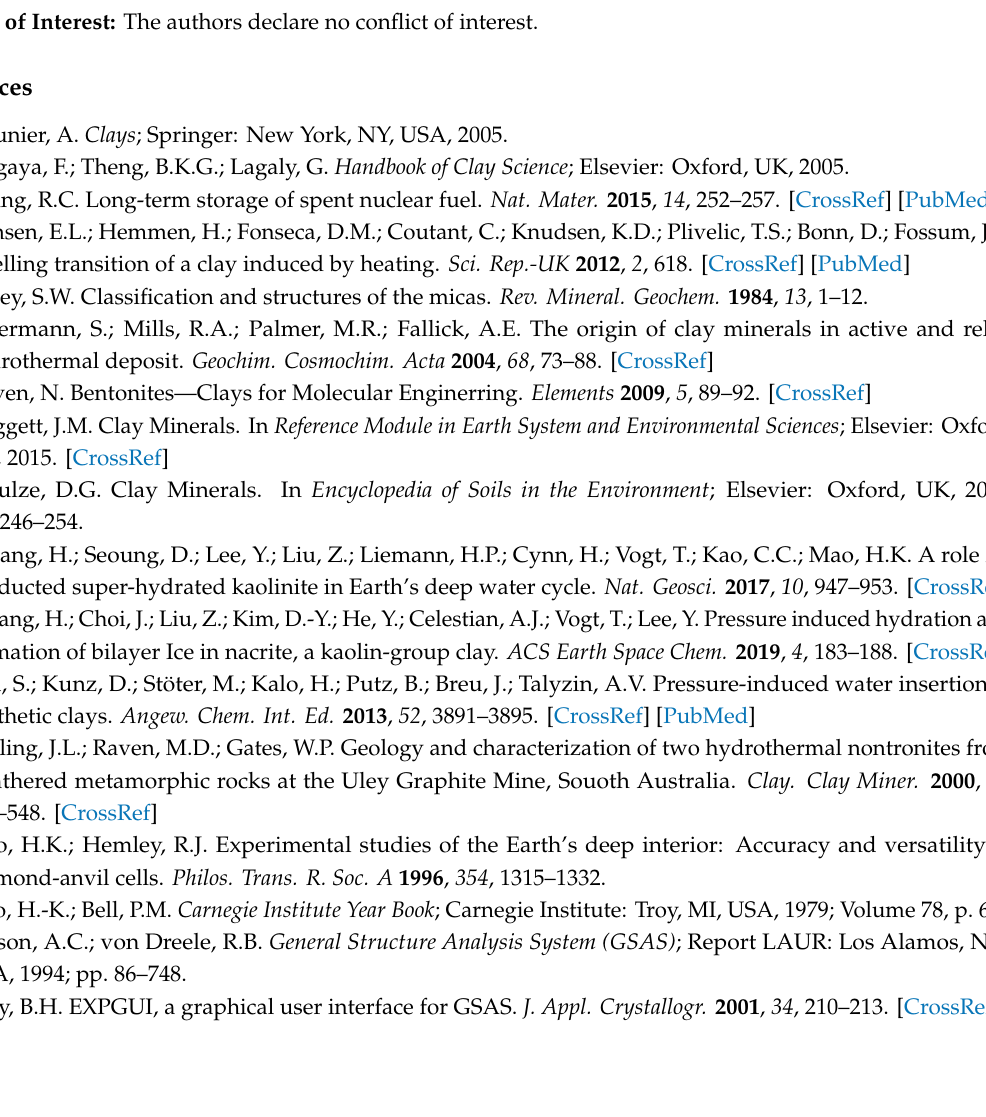
Figure S1: Pressure-dependent changes of the interplane (001) distances of beidellite, montmorillonite, and nontronite in present of silicone-oil and distilled water PTMs. Table S1: Final refined unit-cell parameters, volumes, d-spacing of (001) plane, and FWHM of (001) reflections of beidellite under pressure conditions, at room temperature. Table S2: Final refined unit-cell parameters, volumes, d-spacing of (001) plane, and FWHM of (001) reflections of montmorillonite under pressure conditions, at room temperature. Table S3: Final refined unit-cell parameters, volumes, d-spacing of (001) plane, and FWHM of (001) reflections of nontronite under pressure conditions, at room